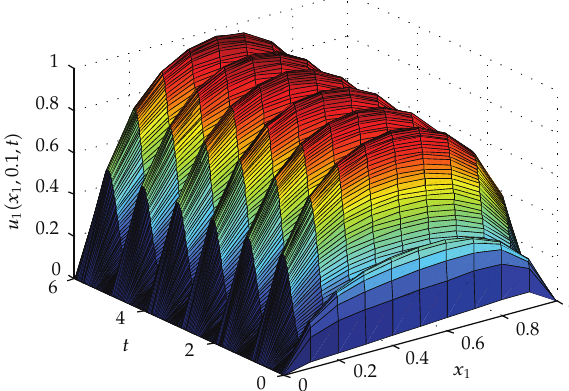
Figure 1: The surface of u 1 (cid:3) t,x 1 , 0 . 1 (cid:4) when x 2 (cid:8) 0 . 1.